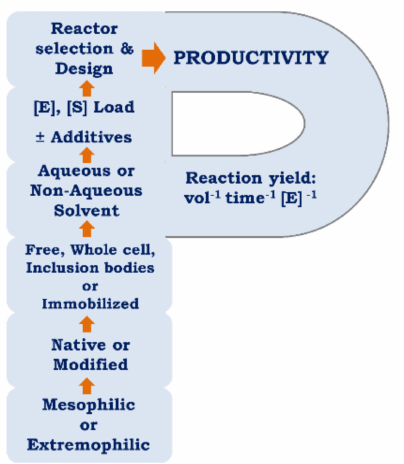
Figure 8. Hierarchical strategy to maximize reaction productivity based on a prioritized optimization of enzymes, solvents, additives, and enzyme reactors. Bottom to top: Step 1., Preferred enzyme activ- ity profile depicted by the direction of arrows: Source options include mesophiles or extremophiles that offer enzymes with activities that are psychrophilic, thermophilic, acidophilic, alkaliphilic, halophilic, piezophilic, and/or organic-solvent tolerant [43]. Step 2., Enzyme source and optimiza- tion: Unmodified, genetically [8,9,32] or chemically modified [15,16] variants. Step 3., Enzyme formulations: Free, inclusion body [13] or immobilized [20,22,38]. Step 4., Reaction solvent: Carrying aqueous or non-aqueous ((e.g., organic solvent [8,14], ionic liquid or super-critical CO 2 [44]). Step 5., Varying [E] and [S] concentrations [2]. Additives or co-factors that improve yields, activity, and productivity [17,44]. Step 6., Reaction mode and reactor design: For example, batch, continuous, solid state or plug flow